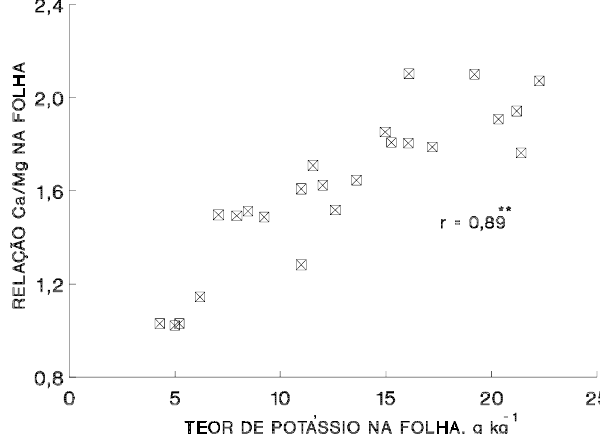
Figura 5. Relação entre Ca/Mg e o teor de potássio no tecido foliar de soja. Resultado de quatro safras. Média de três repetições.